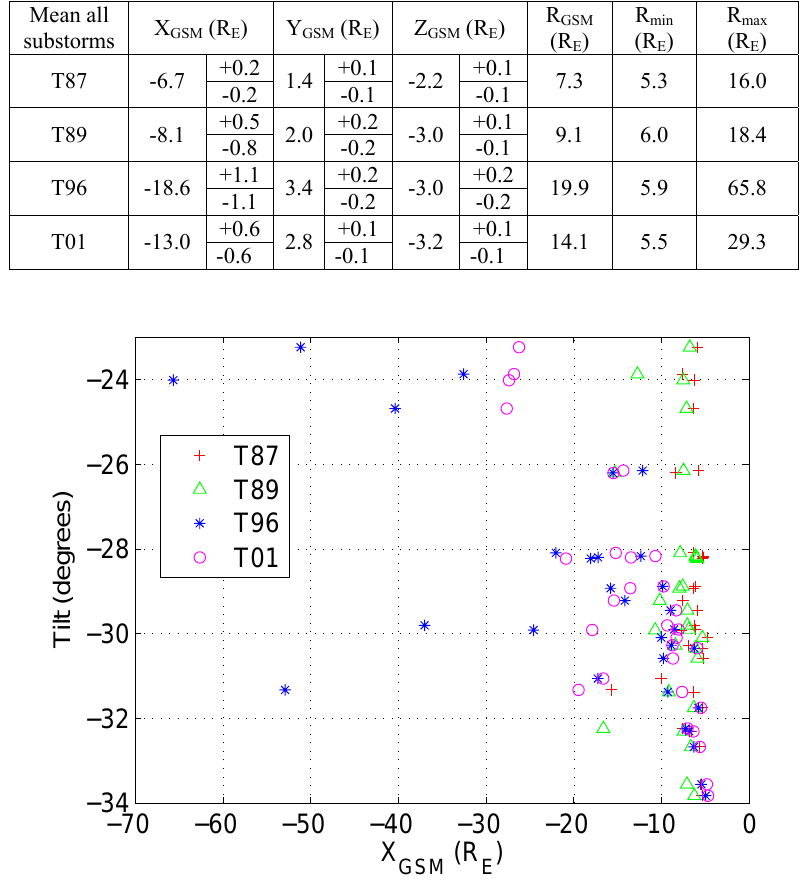
Table 1. Average (X,Y,Z) GSM onset locations determined for the T87, T89, T96, and T01 models. The final three columns give the average, minimum, and maximum radial distance of substorm onsets determined for each model.